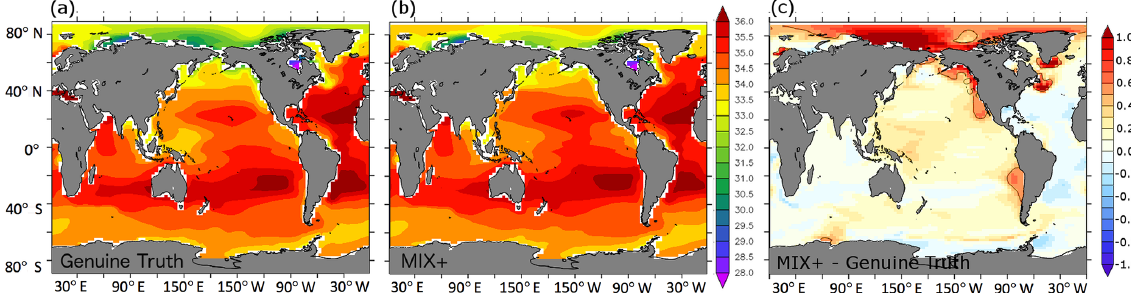
Figure 2. Simulated sea surface salinity in practical salinity units (PSUs) for the historical simulations (see Sect. 2.2.2). Panels (a) and (b) refer to results from the model configurations Genuine Truth and MIX+, respectively. MIX+ features an increased vertical background diffusivity relative to the Genuine Truth (see Table 1). Panel (c) shows the difference between MIX+ and the Genuine Truth.